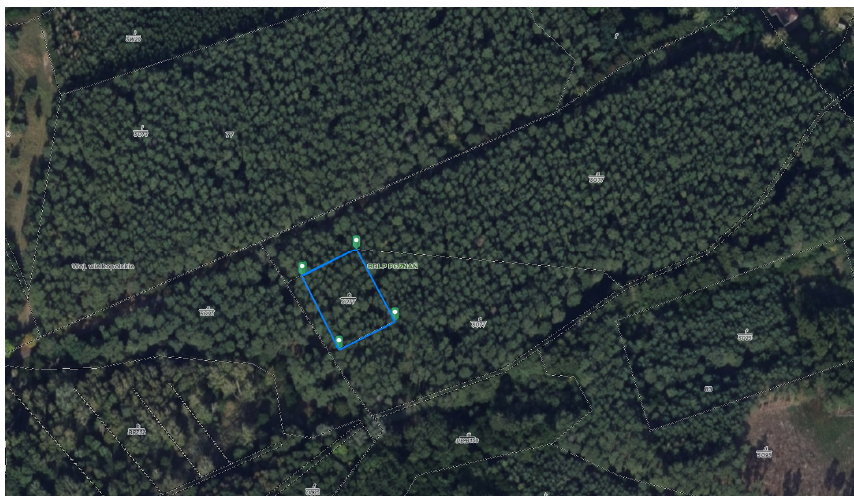
Figure A2. Location of the experimental stand in Poland in 2019.